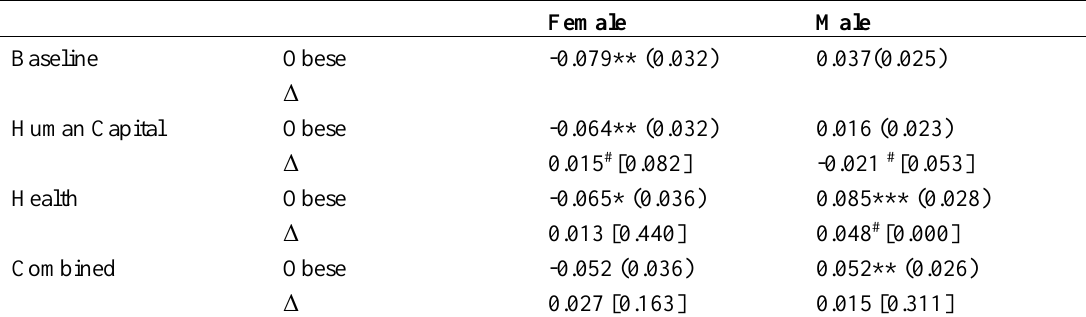
Productivity differences as a potential factor underlying the wage –